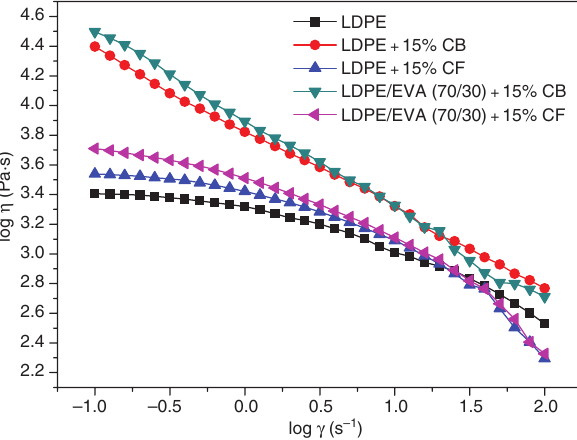
Figure 10: Apparent viscosity as a function of shear rate for com- posites filled with CB and CF.